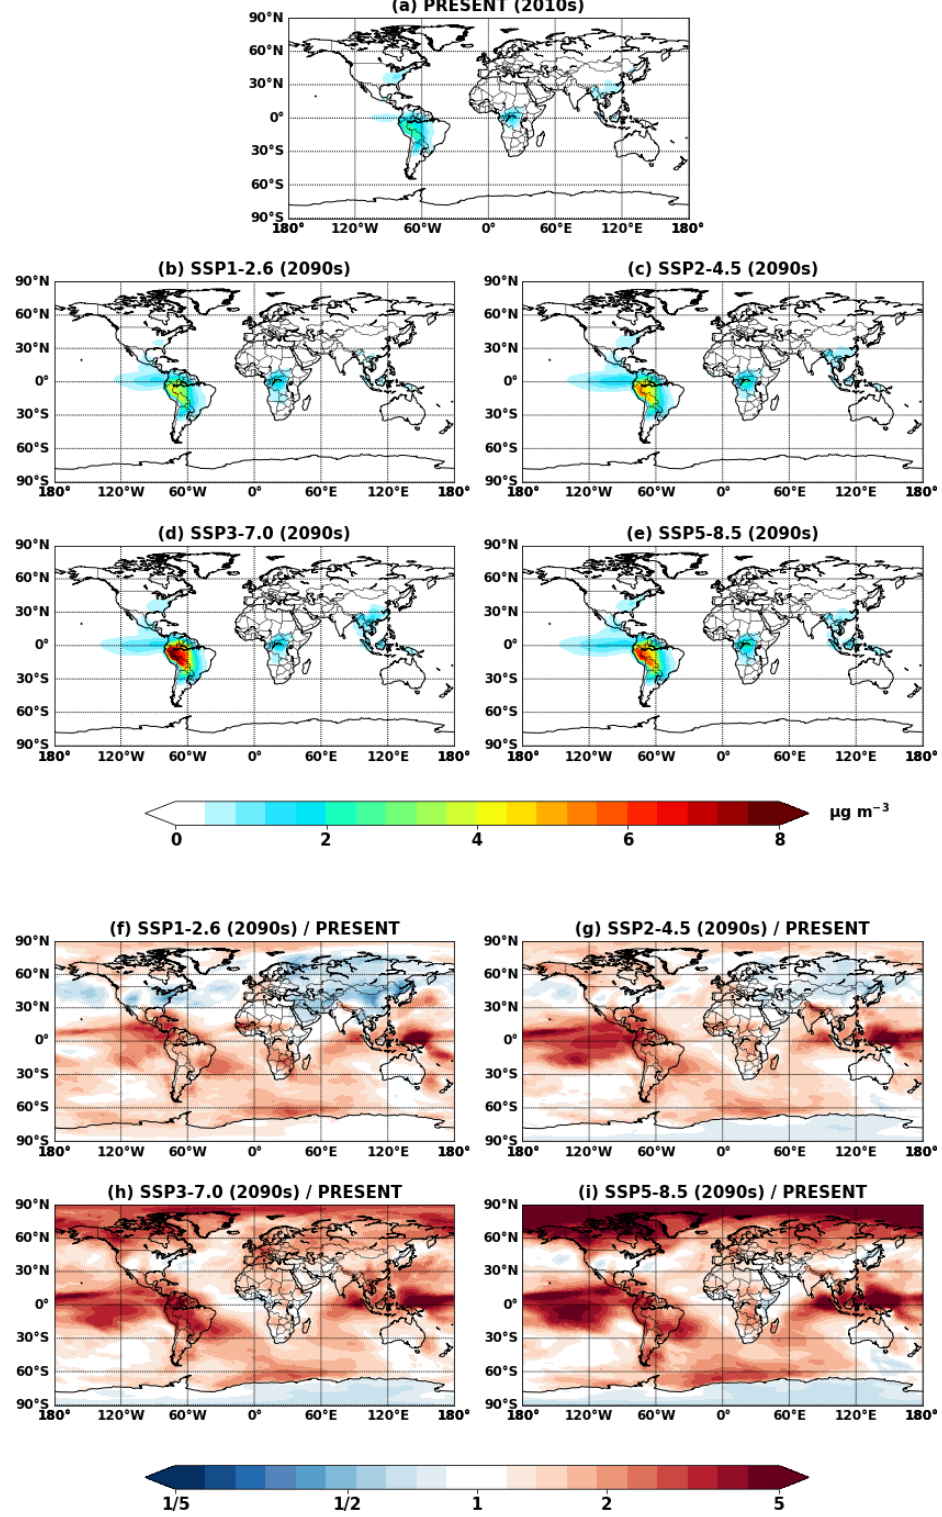
Figure 9. Global mean IEPOX SOA concentrations at the surface simulated in (a) Explicit_CO2_2010 and (b–e) Explicit_ CO2_ 2090_SSPx. (f–i) Ratios of IEPOX SOA between future (b–e) and present (a)